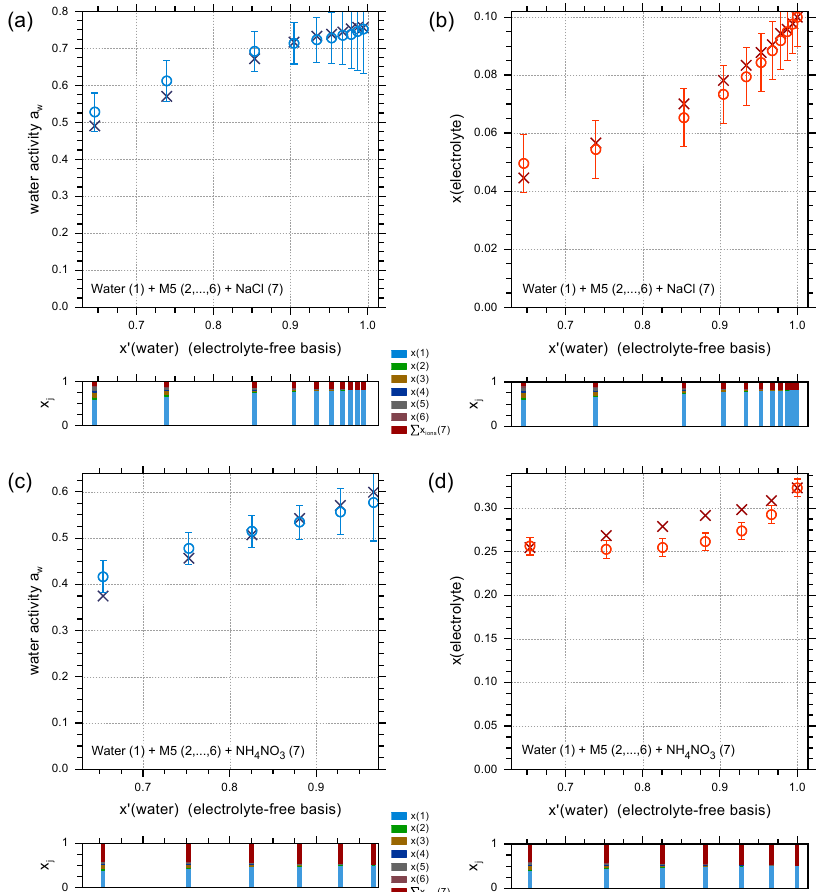
Fig. 12. Water activities and salt solubilities in saturated multicomponent solutions of water (1)+M5 (2, ... ,6)+NaCl (7) and water (1)+M5 (2, ... ,6)+NH 4 NO 3 (7) at 298K, where M5 = malic acid (2)+malonic acid (3)+maleic acid (4)+glutaric acid (5)+methylsuccinic acid (6). Panels (a) and (c) show measured bulk a w data ( ), calculated values ( ), and activity sensitivities (error bars) for the two systems. Panels (b) and (d) show corresponding measured ( ) and calculated ( ) salt solubility limits in terms of mole fractions of the salt on the basis of undissociated electrolyte. Experimental data by Marcolli et al. (2004a). Note the different axis